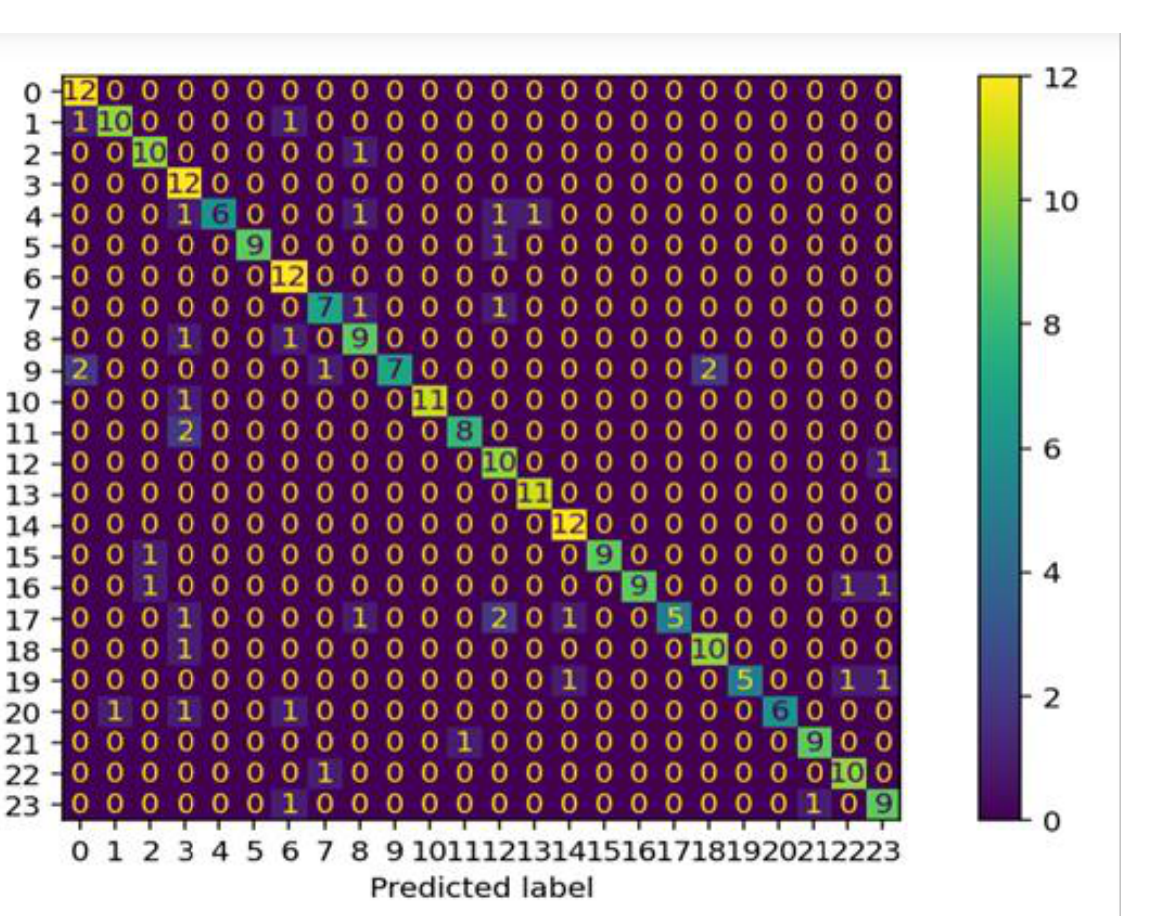
Figure 7. Confusion matrix for the trained model. Table 2. The best-fitted seed after the evolution of the CNN architecture with PFA.